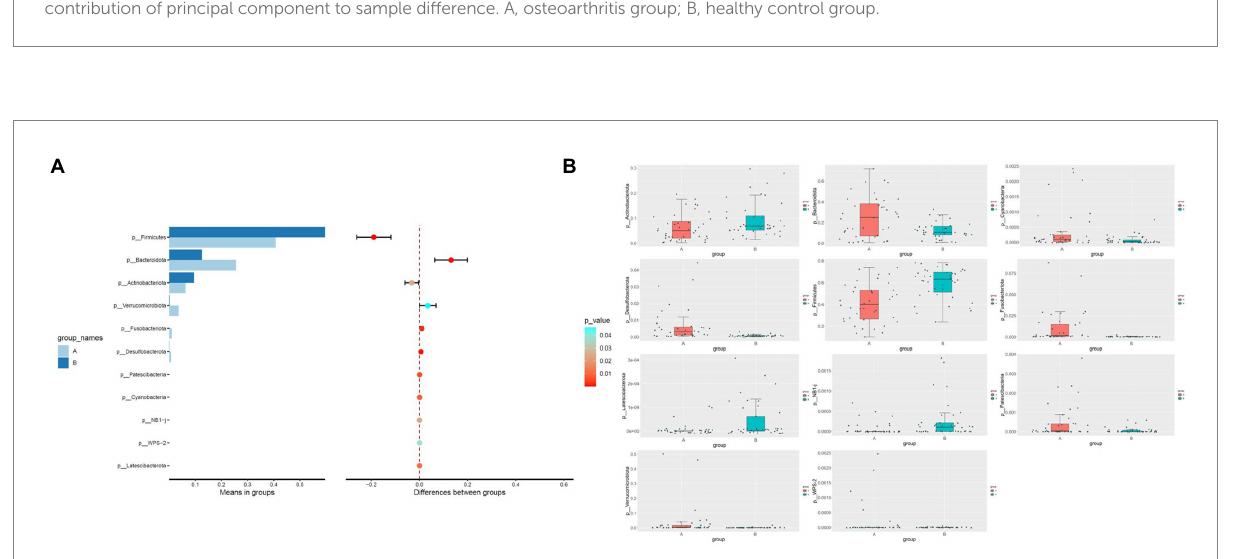
FIGURE 3 MetaStat Analysis. (A) Histogram of different species at phylum level. (B) Box plot of different species at phylum level. A, osteoarthritis group; B, healthy control